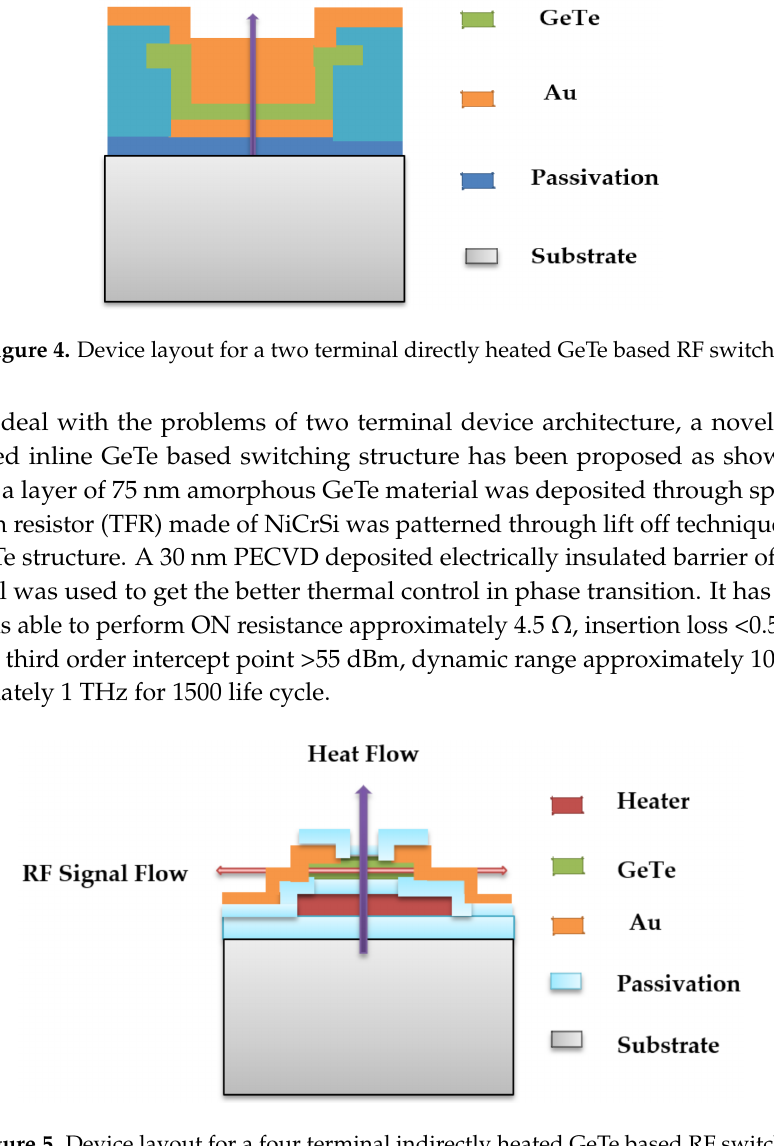
Figure 5. Device layout for a four terminal indirectly heated GeTe based RF